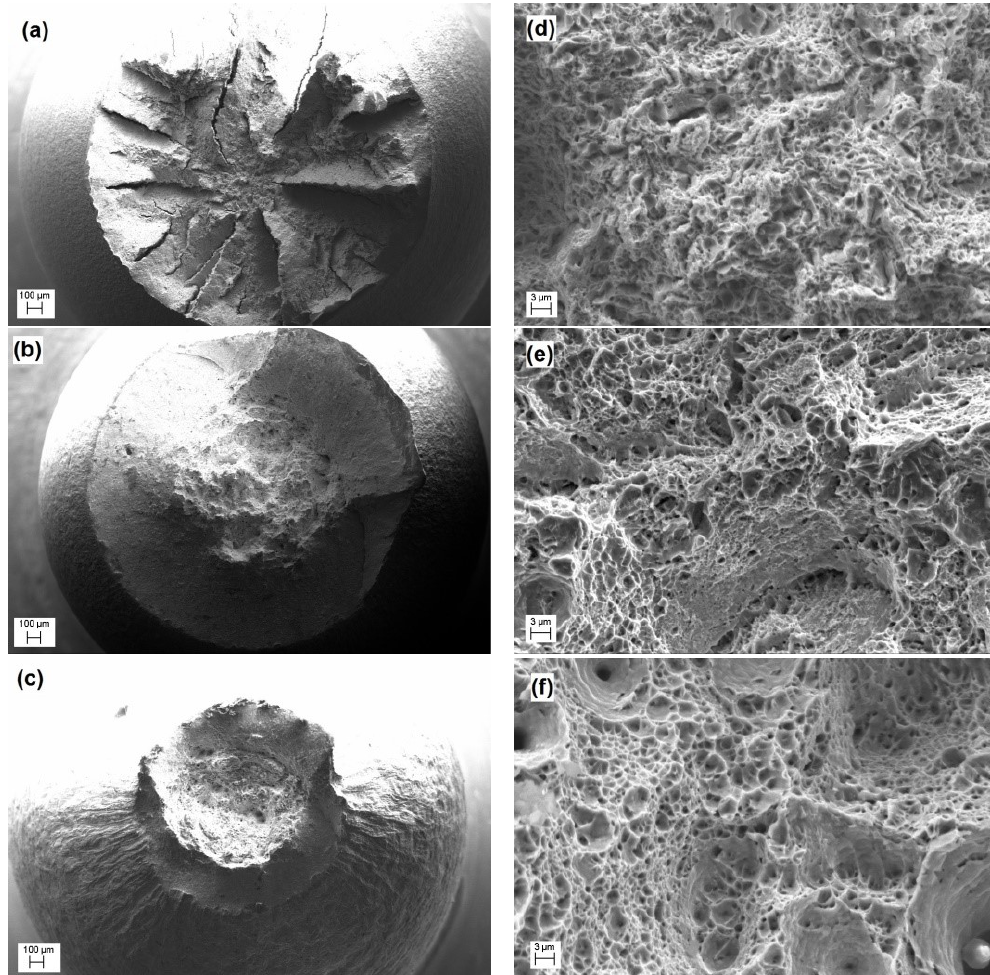
Figure 7: SEM images of fractured surfaces of AISI 431 steel specimen which were tensile tested at ( a and d ) 300, ( b and e ) 623 and ( c and f ) 823